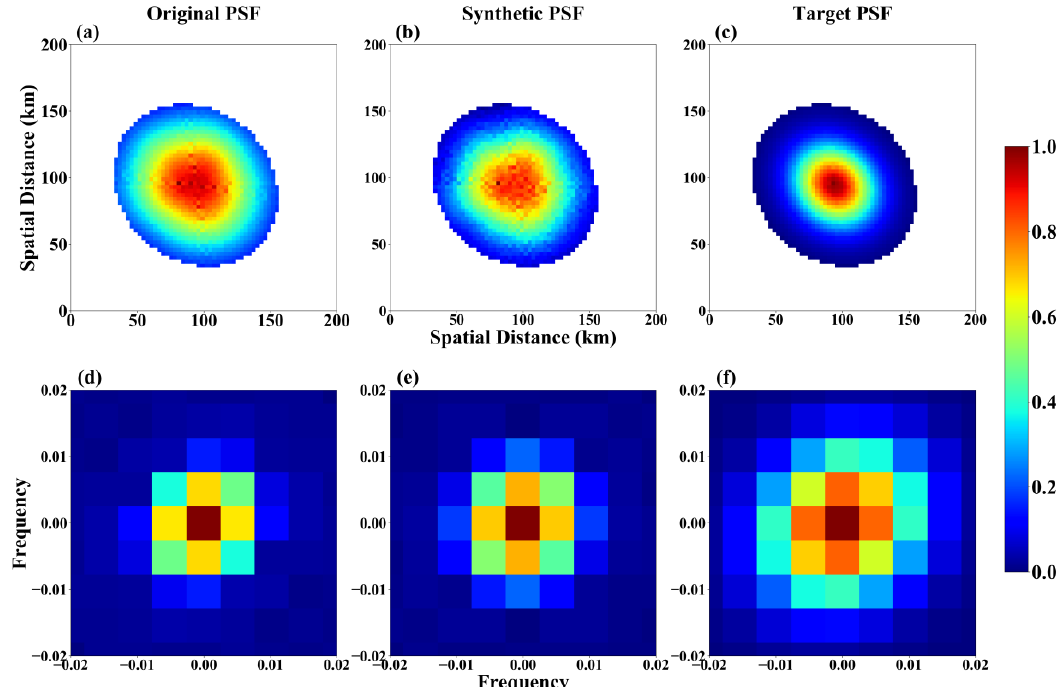
Figure 2. The Backus–Gilbert inversion (BGI) reconstruction from ATMS channel 1 to an AMSU-A point spread function (PSF) at nadir. ( a ) The original ATMS channel-1 PSF, ( b ) the reconstructed AMSU-A-like PSF, and ( c ) the target AMSU-A PSF. ( d – f ) are the Fourier transforms of the PSFs ( a – c ). All response functions have been normalized to 1.0 to facilitate comparisons.